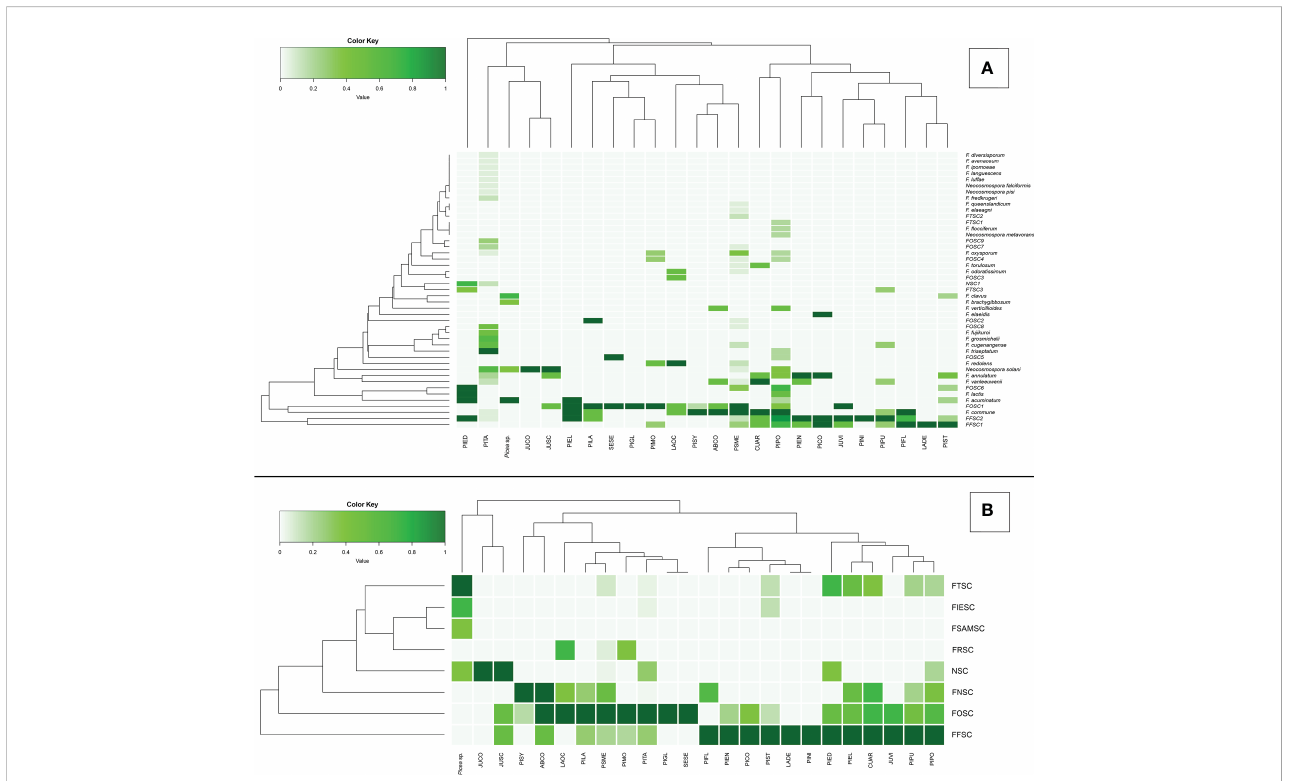
FIGURE 4 Principal coordinates analysis (PCoA) plots of Fusarioid fungi analyzed by the four regions [Paci fi c Northwest (PNW), Southwest (SW), Southeast (SE), and Great Plains (GP)] of the USA, where isolates were collected and the three most common host genera. Abbreviations for species complexes include FNSC - Fusarium nisikadoi species complex; NSC - Neocosmospora species complex; FTSC - Fusarium tricinctum species complex; FRSC - Fusarium redolens species complex; FIESC - Fusarium incarnatum-equiseti species complex; FSAMSC - Fusarium sambucinum species complex; FFSC - Fusarium fujikuroi species complexFOSC - Fusarium oxysporum species